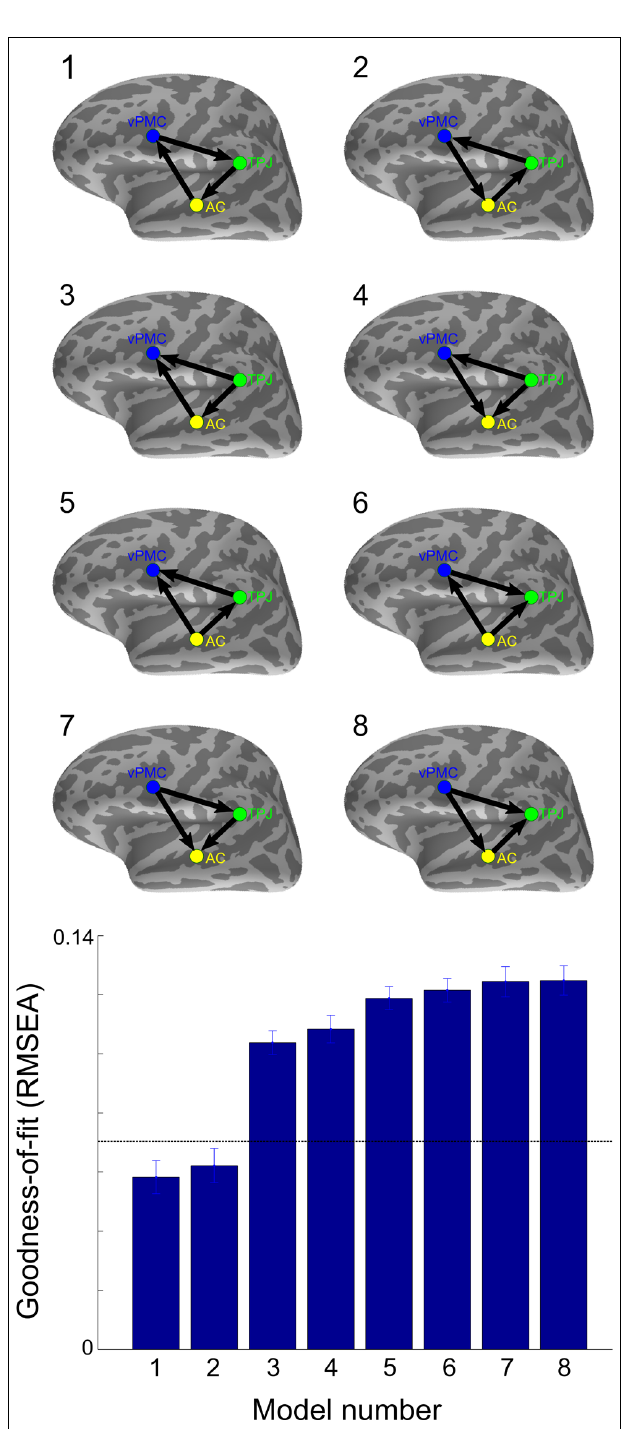
FIGURE 5 | Comparison between models of effective connectivity. RMSEA was applied to test the goodness-of-fit between all unidirectional SEM models between the three functionally interconnected left-hemisphere areas.The horizontal dashed line denotes the cut-off point with RMSEA < 0.07 considered a good fit (Steiger, 2007). Error bars indicate SE. AC, auditory cortex;TPJ, temporoparietal junction; vPMC, ventral premotor